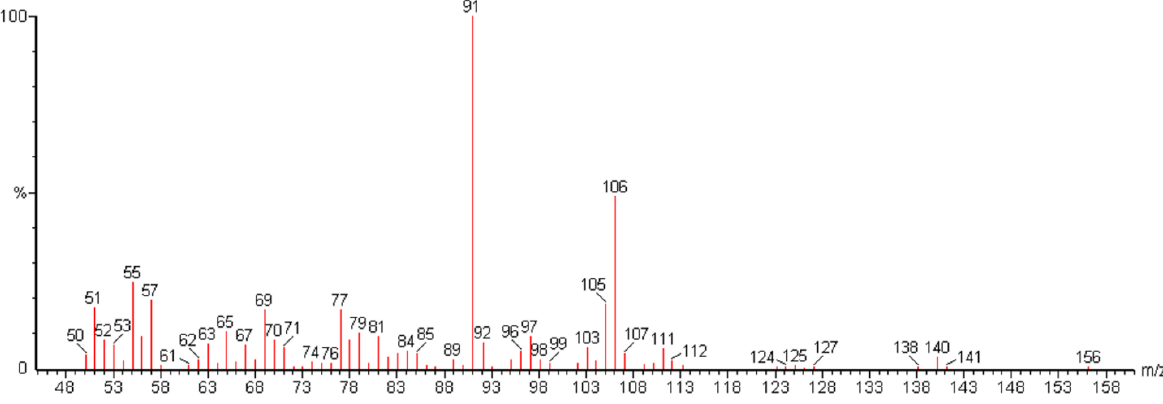
Figure 8. MS spectrum for the peak with a retention time of 13.82 min.